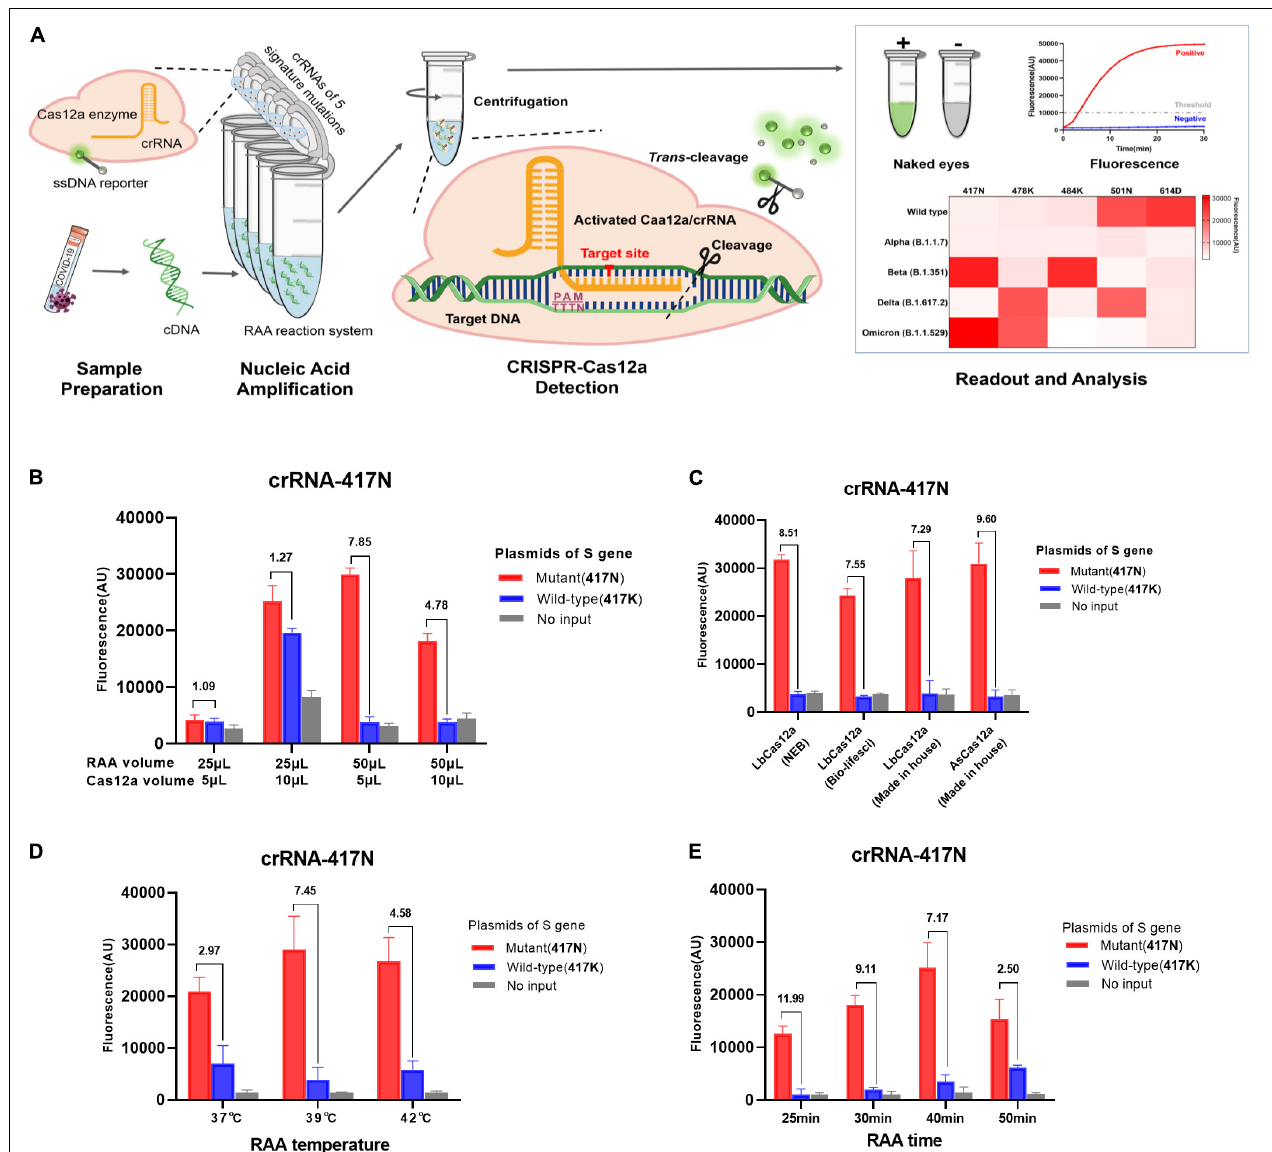
FIGURE 1 | RAA/CRISPR-Cas12a-mediated direct detection of SARS-CoV-2 mutations. (A) Workflow of RAA/CRISPR-Cas12a-mediated assay for SARS-CoV-2 variant detection. In brief, viral RNA is extracted, reverse transcripted into cDNA and amplified by recombinase-based isothermal amplification (left panel). Then, the CRISPR-Cas12a reagents are centrifuged and mixed with amplification products to initiate CRISPR-Cas12a-mediated cis- cleavage of the amplified products and trans- cleavage of reporter DNA (middle panel). Finally, the detection results are measured by a fluorescent detector or read directly by the naked eye under a blue light imager and presented in a heat map (right panel). (B–E) Optimization of RAA/CRISPR-Cas12a-mediated assay by using the plasmid DNA of K417N mutant (1 × 10 4 copies/ µ l) and wild-type spike gene (1 × 10 6 copies/ µ l) as template. The detection efficiency was evaluated according to the volume of RAA and CRISPR-Cas12a reaction mixture (B) , different sources and types of Cas12a proteins (C) , RAA reaction temperature (D) , or reaction time (E) . Fluorescence values are represented as mean ± standard deviation (SD) of three replicates. The fluorescence ratio of sample over control is presented at the top of each panel. The amino acid is indicated in the brackets. No input refers to no DNA